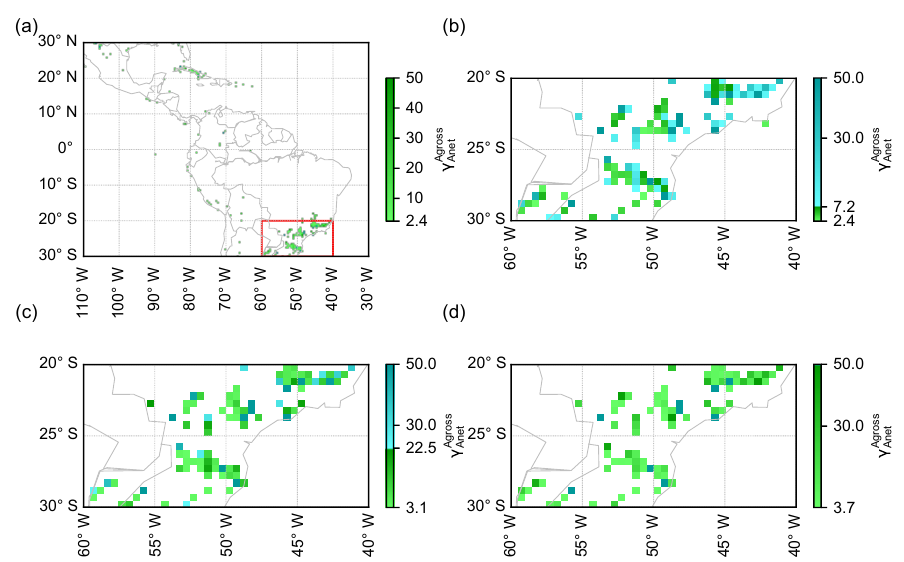
A gross ) in 0.5 ◦ × 0.5 ◦ grid cells in Latin America (same region as Poorter et al., 2016) A net A gross <2.4 are masked. Panel (b) is the A net A gross A gross >7.2 and with 2.4< γ <7.2 are shown A net A net